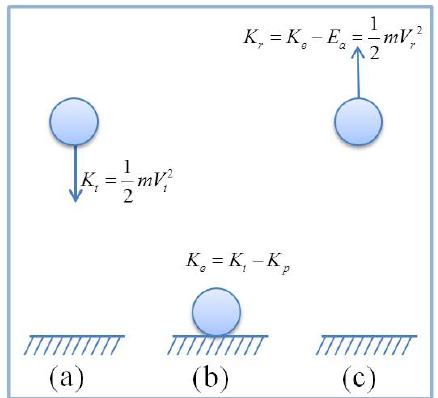
Figure 7. A diagram of the particle bounce process as a simple energy balance for normal impacts showing ( a ) the incident particle approaching the surface, ( b ) the particle at full compression before rebound, and ( c ) the rebounding